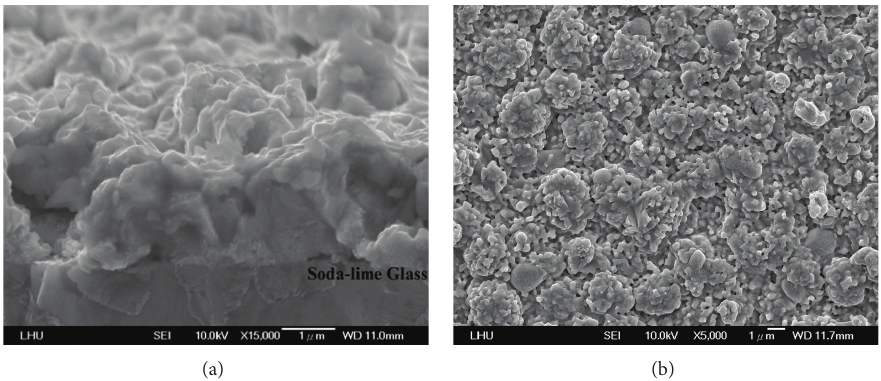
Figure 10: (a) Cross-sectional and (b) top-view SEM images of CIGS film selenized at 550 ∘ C for 20